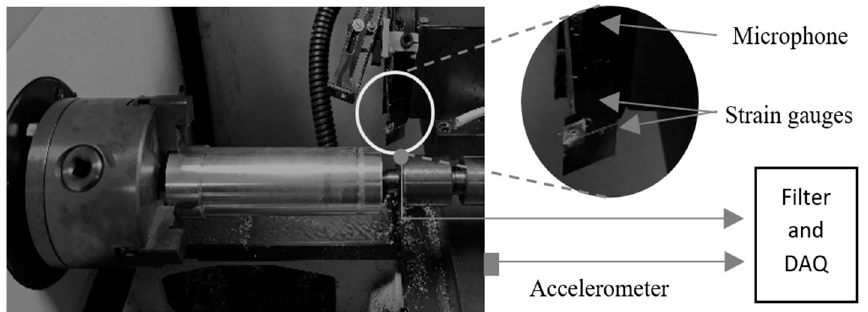
Figure 2. The experimental apparatus.